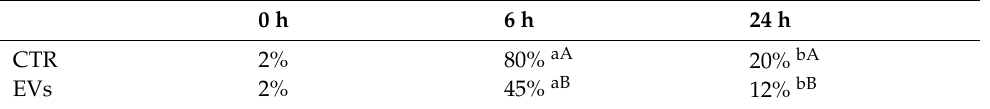
Figure 3. Endometrial cytology stained with dip quick stain ( × 100). ( A ) Negative endometrial cytology with absence of inflammatory cells. ( B ) Positive endometrial cytology with few endometrial epithelial cells and hypersegmented neutrophils (scale bars 20 μ m). Table 3. Percentage of polymorphonuclear neutrophils in treatment and control groups.